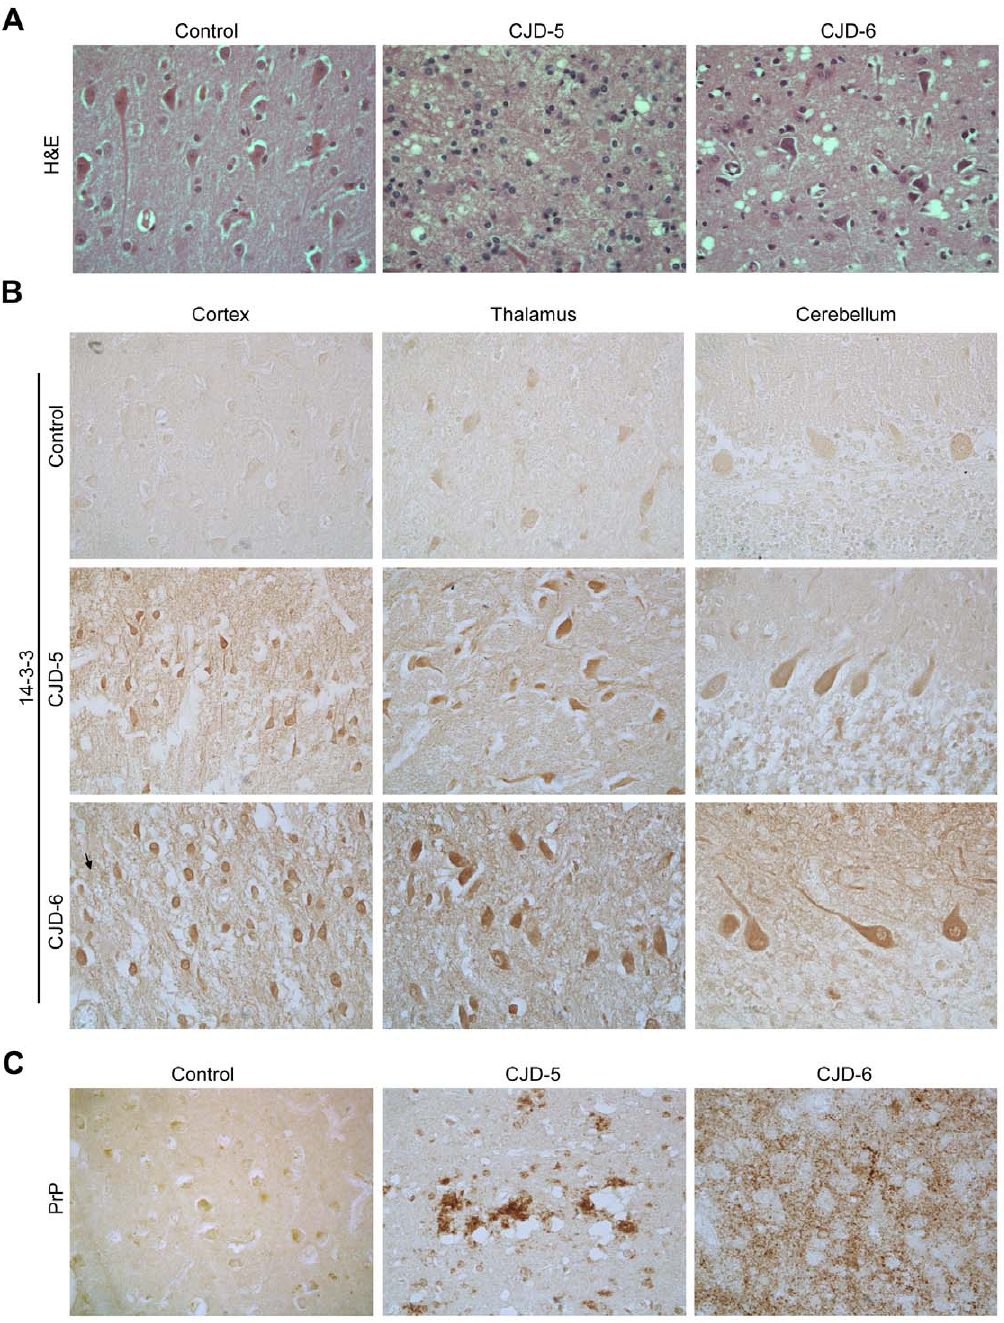
Figure 6. Postmortem examination of 14-3-3 in the brain of sCJD cases. A. H&E staining was performed in the post mortem brain cortex obtained from of CJD patients 5 and 6 (CJD-5 and CJD-6) and one patient with cerebral infarction (control, non-affected hemisphere). B. 14-3-3 protein expression levels were monitored by immunohistochemistry in post-mortem brain sections of patient CJD-5 and CJD-6 compared to a control subject. Brain cortex, thalamus and cerebellum were analyzed. C. In addition, the expression pattern of PrP was also analyzed in cortex presented in A. Magnification 400 6 .